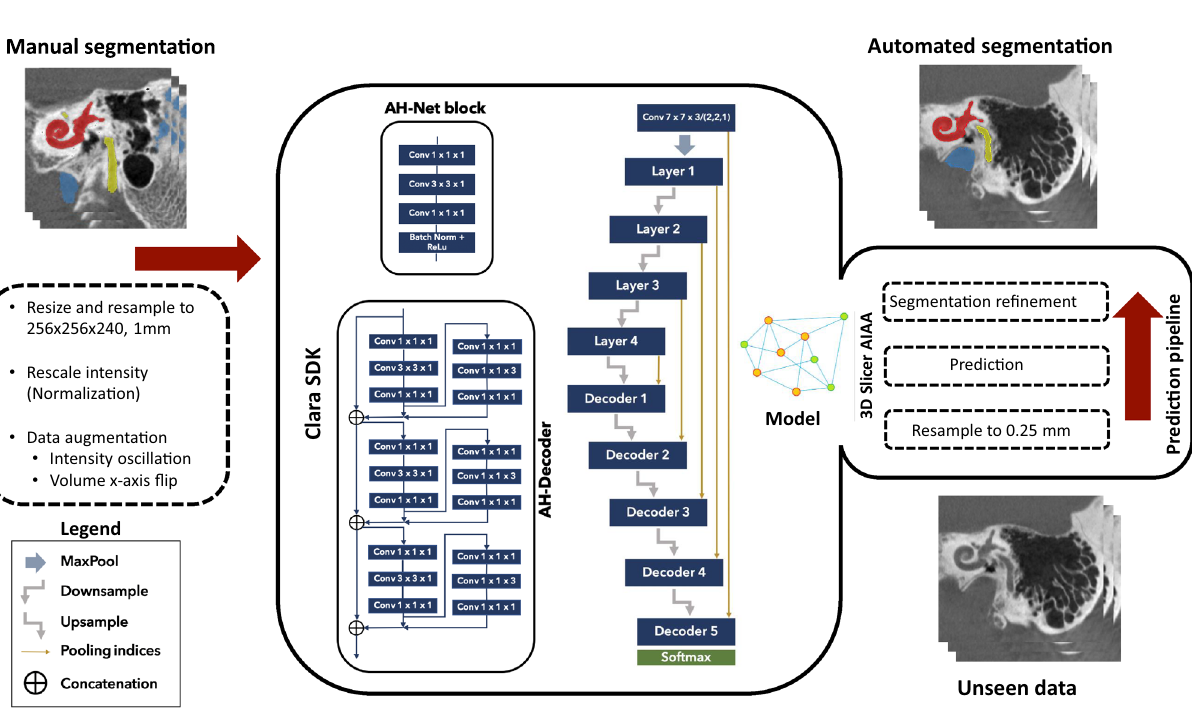
Figure 2. Auto-segmentation pipeline. Manual segmentation of temporal bone structures from computed tomography were used to train a deep learning model using a 3D convolutional neural network. Automated segmentation of the structures was then performed on a testing set in the 3D Slicer